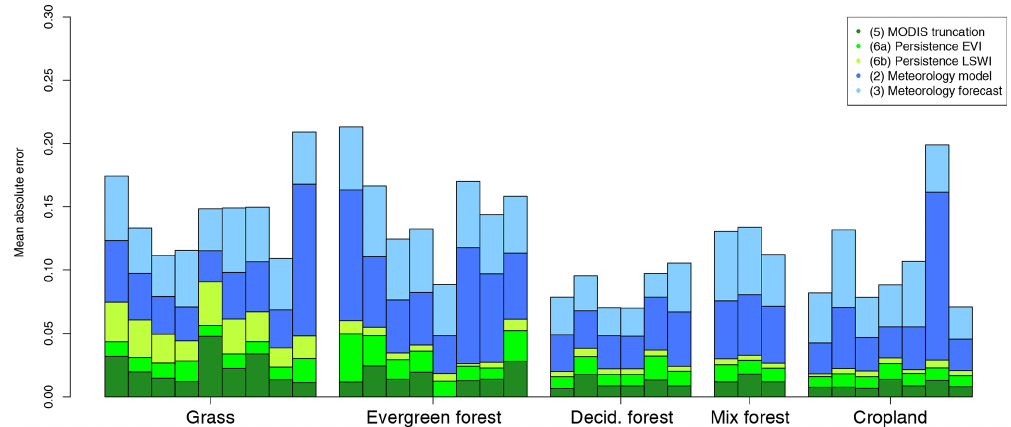
Figure 9. Mean absolute error for different error sources at each flux observation site. The meteorological error (2, meteorological model, + 3, meteorological forecast) is the dominant contributor at each site and has a similar contribution for different vegetation types. The data truncation error (4) has a stronger influence on some grass sites, likely due to the highly EVI variability resulting from mowing and regrowth during the growing season. The order of the flux site is the same as in Fig. 6.